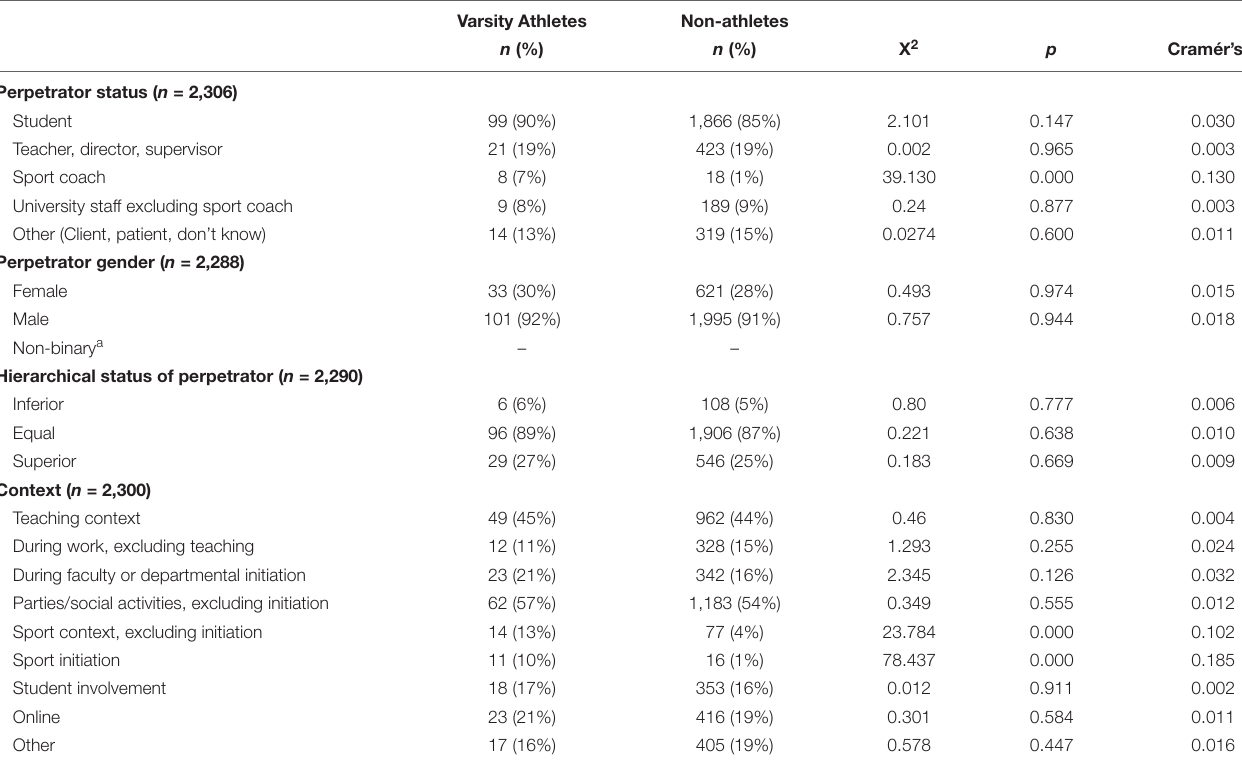
TABLE 3 | Sexual violence characteristics comparisons between varsity athletes and non-athletes reporting at least one form of sexual violence at